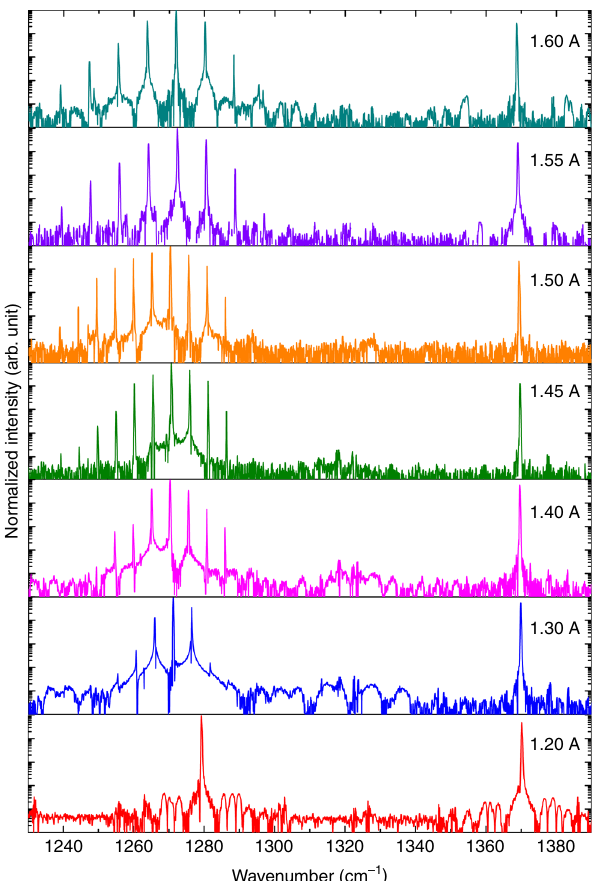
Fig. 2 On-chip generation of single mode and multimode comb from a single mid-IR QCL. Lasing mid-IR spectra of the 4-mm long DFB QCL evolving with currents from 1.2 to 1.60 A at room temperature in continuous wave